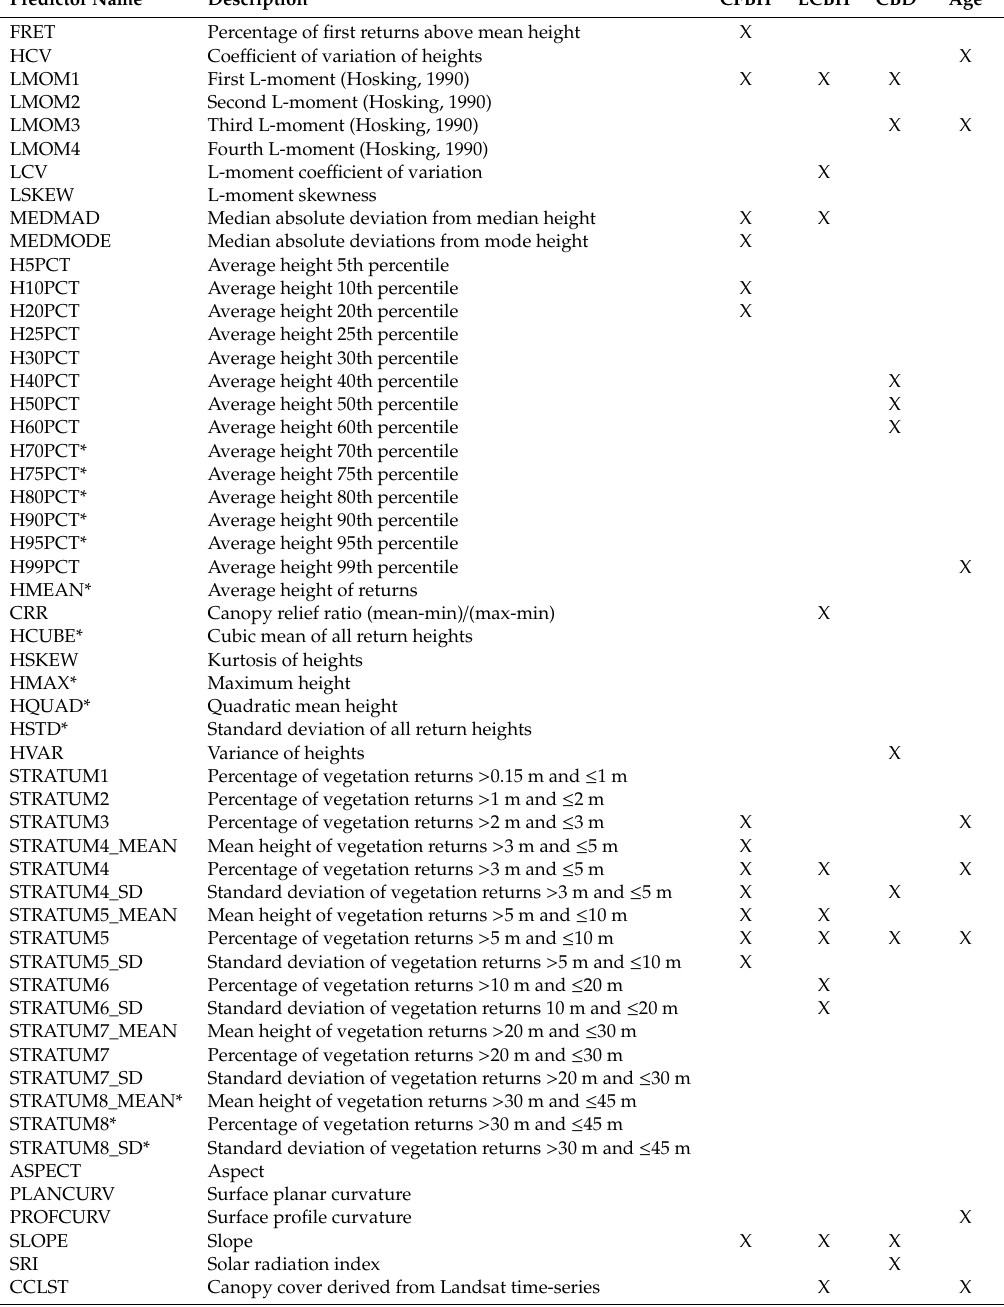
Table 2. The 55 predictors evaluated in the model development of the four canopy fuel attributes. Selected predictors in the final models for crown fuel base height (CFBH), live crown base height (LCBH), canopy bulk density (plotwise total CBD based on tree cylinder shape), and stand age are indicated with ‘X’. All height measurements are in